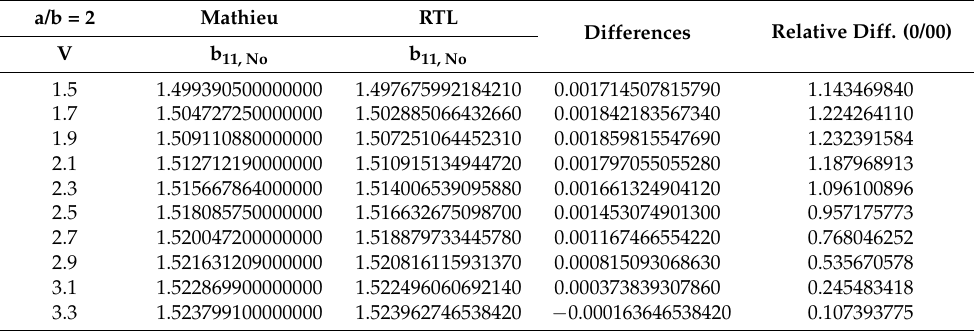
Table 4. Comparison of ellipse for the fundamental modes.